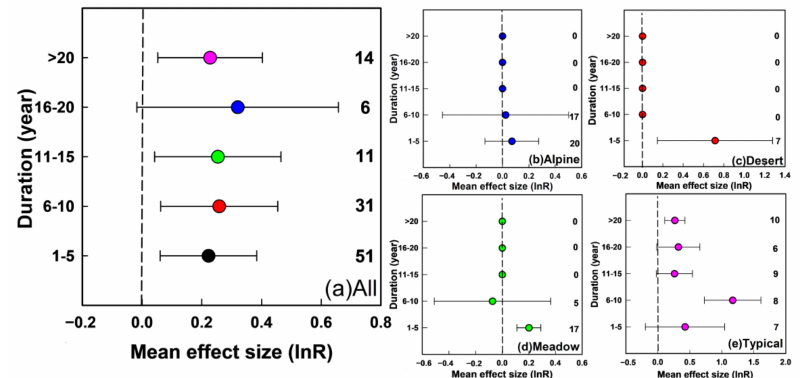
Figure 6. Effect value of underground biomass under different enclosure years ( a ) and response of different grassland underground biomass to enclosure ( b – e ). The values are calculated effect sizes and 95% confidence intervals. Sample sizes are given to the right of the graph.